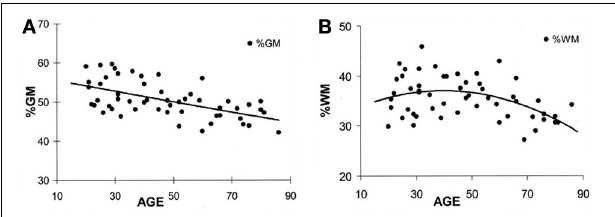
FIGURE 2 | (A,B) These plots are from Ge et al. (2002) and reflect different trajectories of white matter (WM) and gray matter (GM) over the life-span. The percent of GM volume total brain (TBV) volume declines with age whereas the percentage of WM to TBV shows and increase followed by decline later in life. Note that the age at which an individual is injured occurs not in a static brain, but rather in a brain that has age-dependent changes occurring simultaneously with the age when injury occurs. Reproduced with permission from The American Society of Neuroradiology.